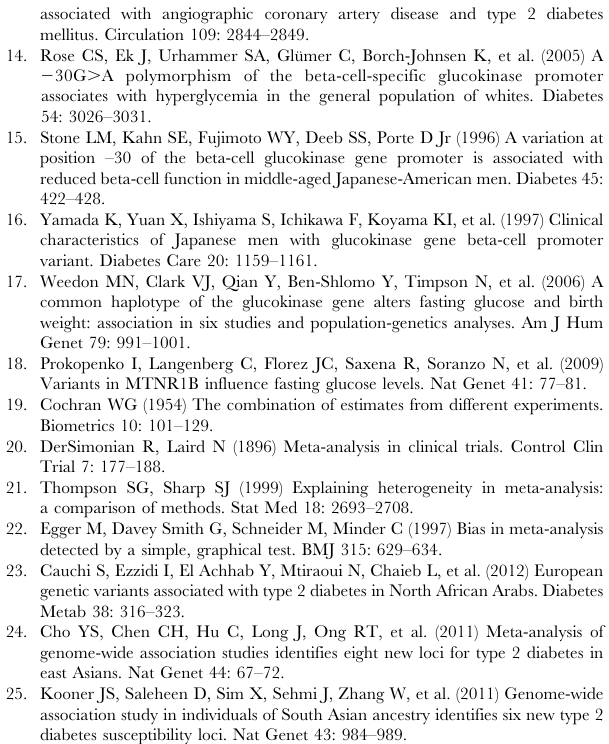
Figure S1 Study selection process. Figure S2 Begg’s funnel plot of GCK 2 30G . A polymorphism and T2D